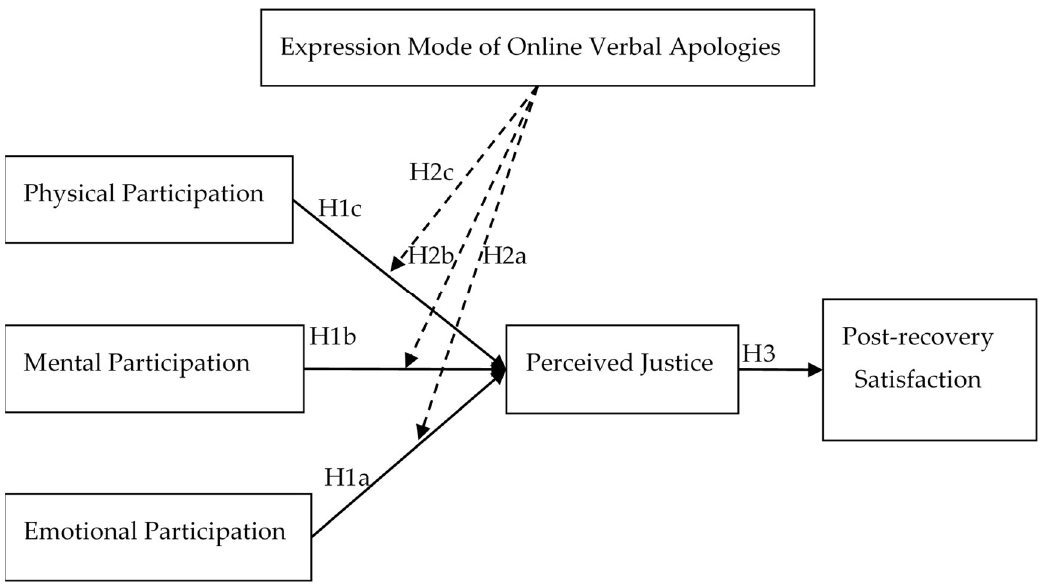
Figure 1. Research model. Note: H is the abbreviation for “Hypothese”.